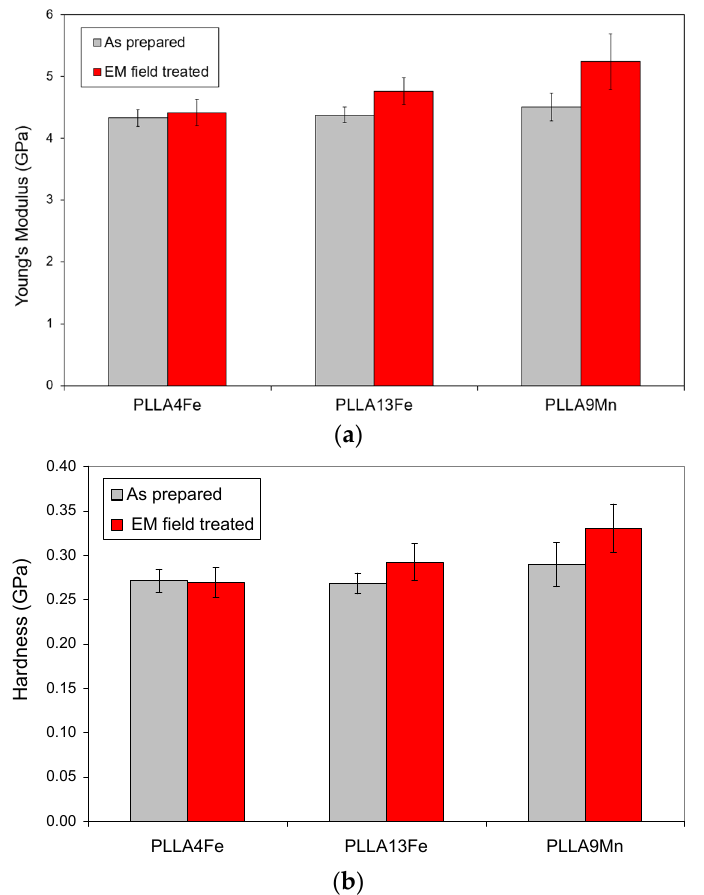
Figure 8. Mechanical properties of PLLA composites reinforced with Fe 2 O 3 and MnFe 2 O 4 MNPs, before and after EM field treatment: ( a ) Young´s Modulus and ( b ) Hardness.